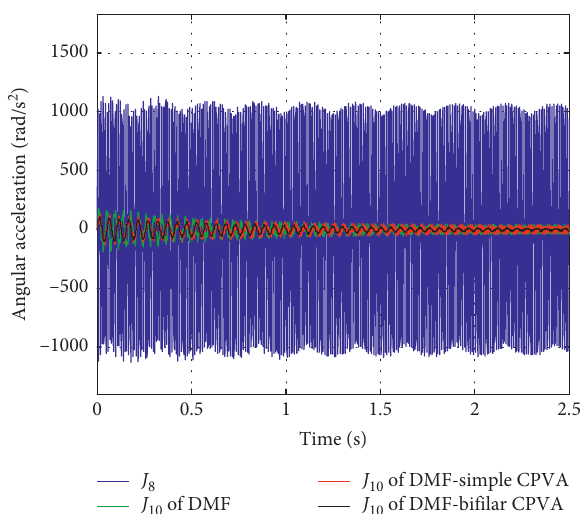
Figure 12: Angular acceleration curves of J